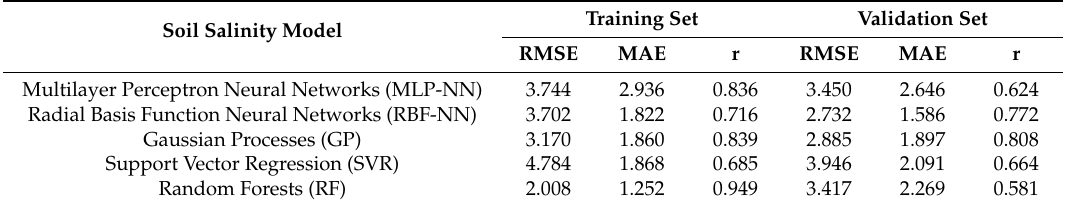
Table 4. Performance of the five soil salinity models using both the training set and the validation set in this research. RMSE: root mean squared